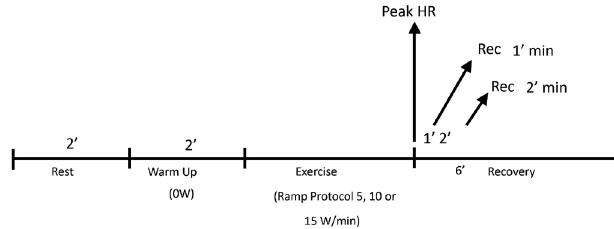
Figure 1. Timeline of experimental protocol (see Experimental Protocol section for more